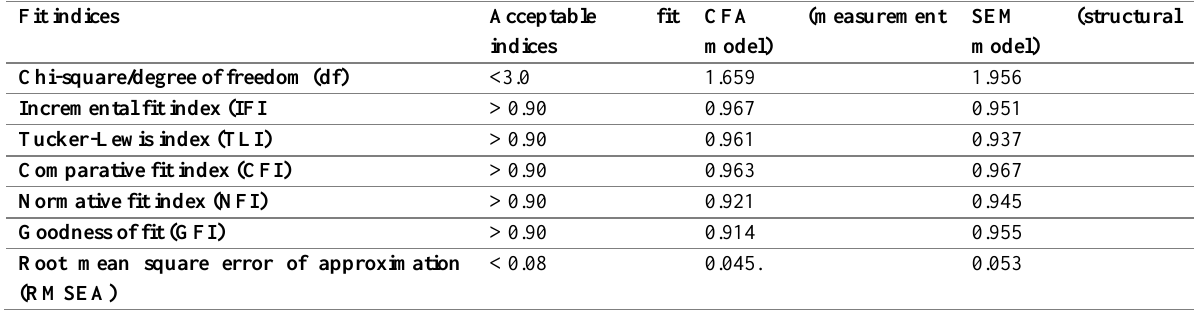
Table 7: Model fit statistics.